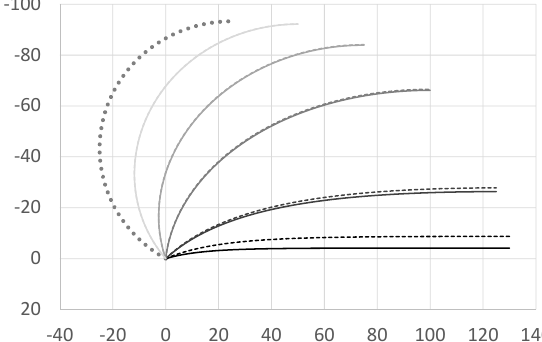
Figure 7: Reference and morphed shapes of corrugated laminates [90, 0 2 ] (solid lines) and [90 3 ] (dashed lines) with maximum corru- gation amplitude; stretches: 2 , 3 , 4 , 5 , and 5.2